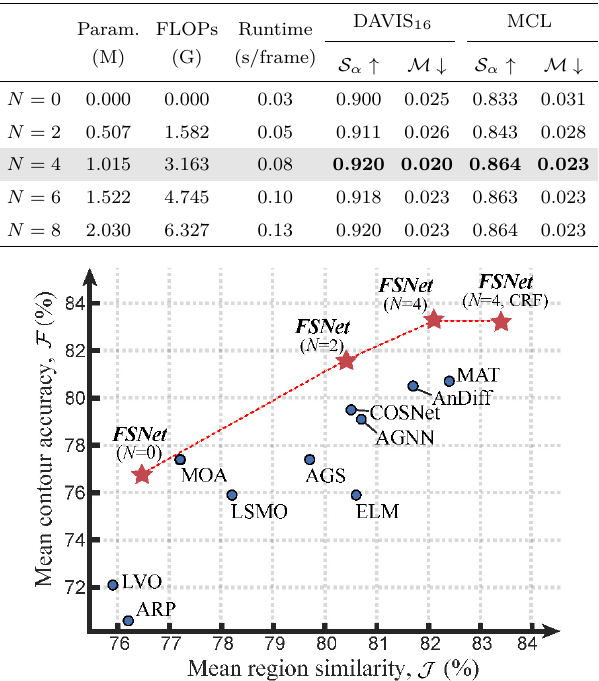
Fig. 8 Mean contour accuracy ( F ) versus mean region similarity ( J ) scores on the DAVIS 16 dataset [35]. Circles indicate U-VOS methods. Four variants of our FSNet are shown in bold-italic . N indicates the number of bidirectional purification modules (BPM) and CRF means CRF [84] post-processing was used. Compared to the best unsupervised VOS model, MAT [25] also with CRF, the proposed method FSNet ( N =4, CRF) achieves the new SOTA by a large